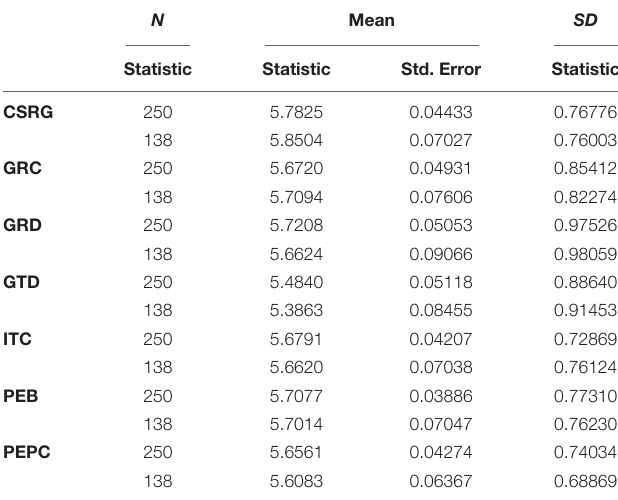
TABLE 1 | Results of early and late response.